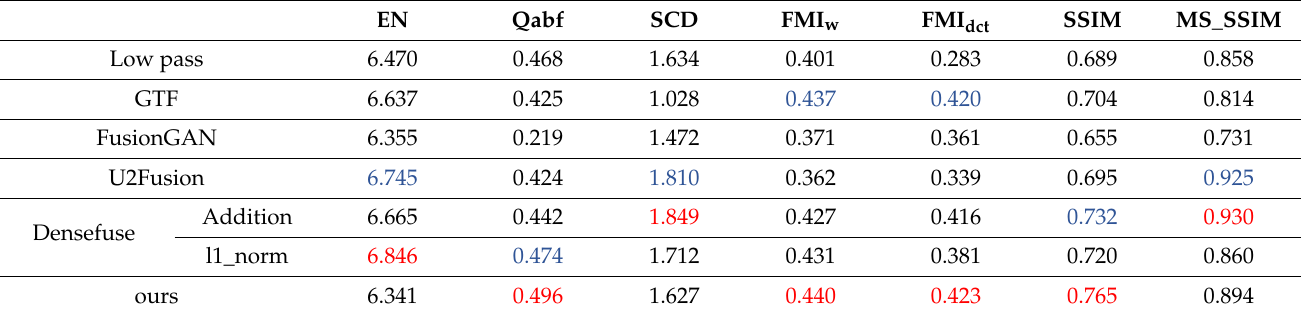
Table 2. The average values of quality metrics for twenty fused images in the TNO dataset (red: the best; blue: the second best).